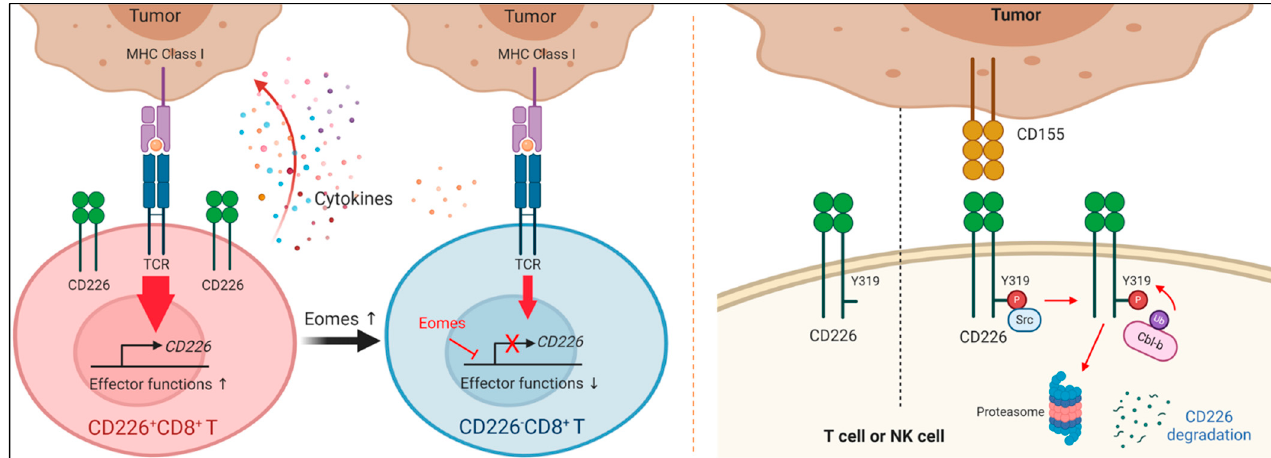
Figure 4. Mechanisms of CD226 downregulation. ( Left ) Tumor microenvironment promotes the accumulation of a subset of CD8 + T cells that lose CD226. CD226 is transcriptionally downregulated in an eomesodermin (Eomes)-dependent and a PVR-independent manner. CD226 downregulation is abolished in Eomes-deficient CD8 + T cells. Eomes directly interacts with regulatory elements of the CD226 gene. ( Right ) CD226 expression is posttranslationally regulated through the ubiquitin–proteasome pathway. After engagement with PVR, mouse CD226 is phosphorylated at Y319 by Scr kinase, subsequently recruiting E3 ubiquitin ligase Cbl-b, which induces ubiquitination-dependent proteasomal degradation of phosphorylated CD226.